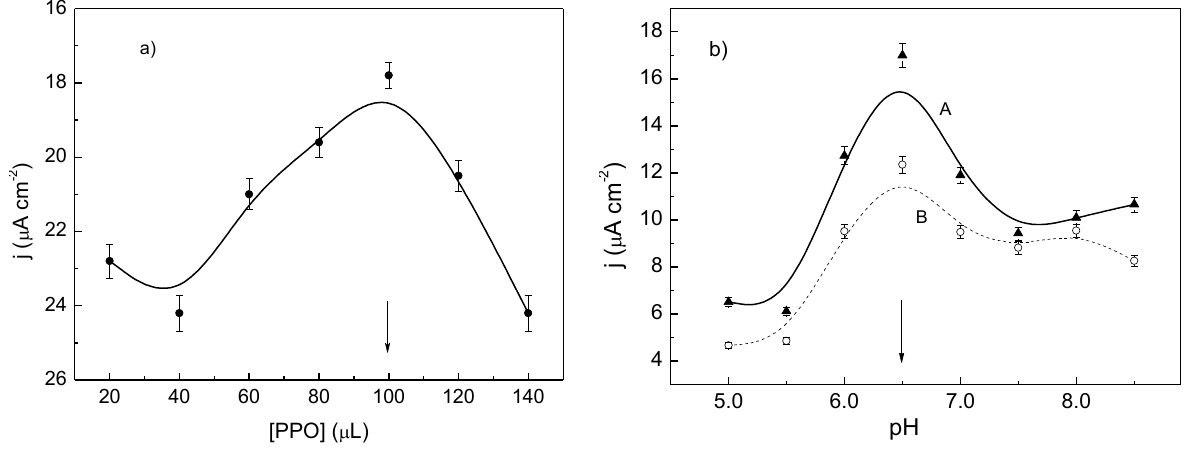
Figure 5. Responses of current for PPy/Tyr films prepared in pyrrole, phosphate buffer, and catechol at different: ( a ) volumes of crude extract of avocado; ( b ) pHs without ( A ) and with ( B ) benzoic